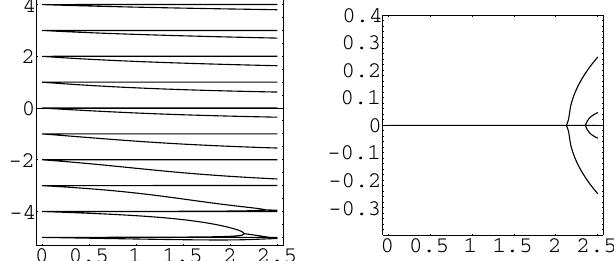
FIG. 68. Real and imaginary part of the coherent tune shift in units of the synchrotron tune with an incoherent tune shift of (cid:6) 2 : 5 Q at (cid:6) (cid:16) versus the electron density in units of 10 12 m (cid:2) 3 s z (cid:3) 10 11 protons in the SPS, computed by for a bunch of N b Perevedentsev [72].